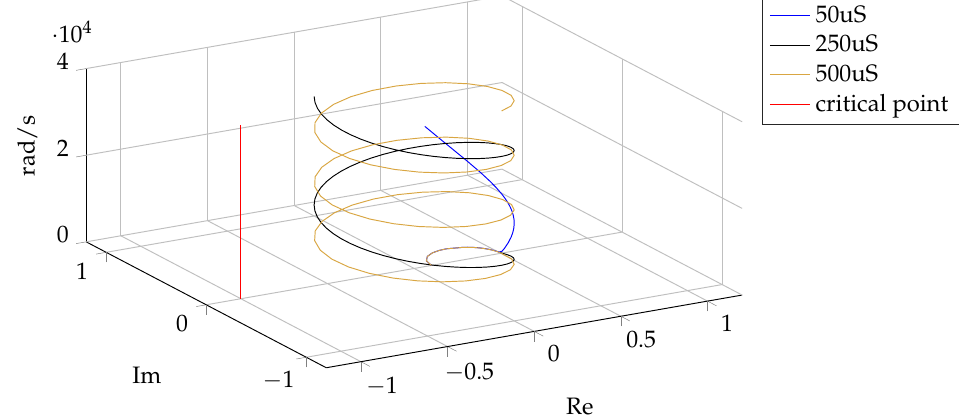
R e I m R S R HuT Figure 9. Nyquist curve for resistive impedance PHiL in dependence of the quotient of resistance R S